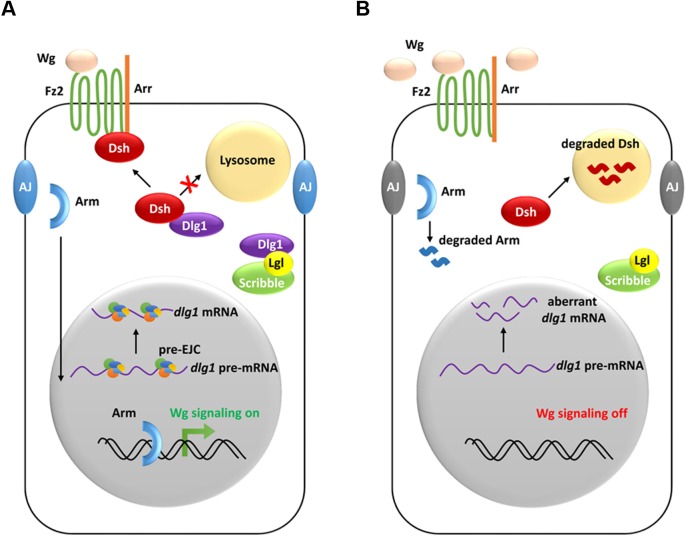
A model showing how the pre-EJC functions in the Wg signaling.(A) In wildtype wing disc epithelial cells, the pre-EJC activity is required for precise splicing of target transcripts, including dlg1. Dlg1 protein functions independently from its role in cell polarity determination to prevent Dsh protein from degradation in the lysosome. Stabilized Dsh works together with Fz2 and Arr, two Wg co-receptors, to facilitate Wg signal reception. Consequently, through a series of cytoplasmic events, Arm protein becomes stabilized, which translocates to the nucleus to activate Wg target gene transcription. (B) When the pre-EJC activity was defective in wing disc epithelium, precise splicing of dlg1 gene is not maintained. Decreased Dlg1 production is not sufficient to stabilize Dsh, resulting in reduced Wg morphogen reception. As a result, Wg is accumulated in the extracellular space of the epithelium, which ultimately fails to protect Arm from degradation, hence reduced Wg signaling.